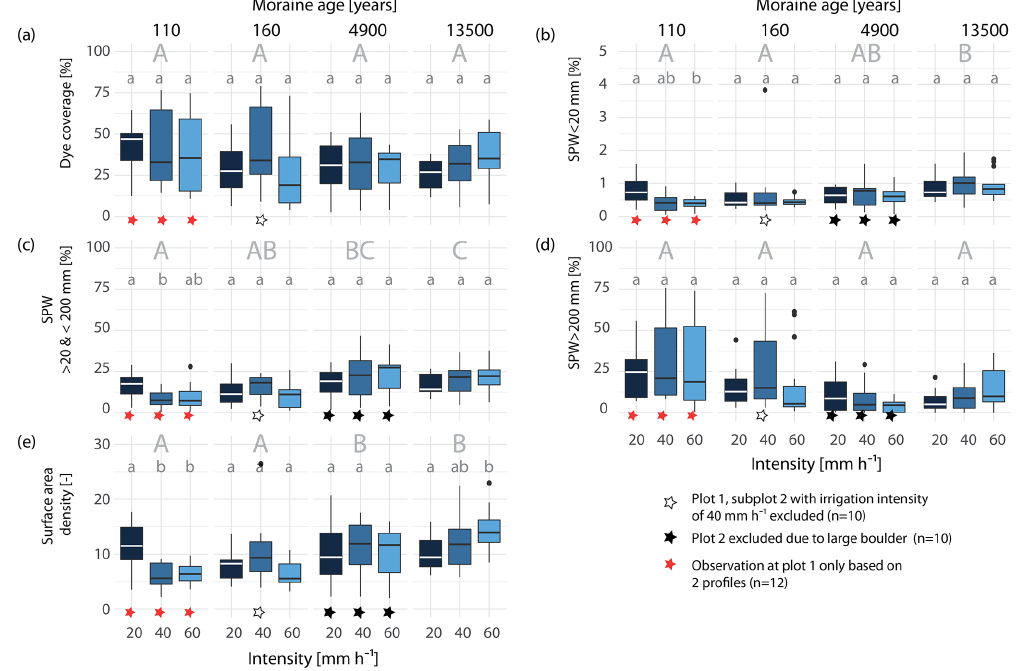
Figure 5. Box plots of dye staining characteristics compared across the three irrigation intensities and the four age classes (each box plot shows the data of 3 plots à 5 profiles, 15 profiles in total). (a) Dye coverage (volume density) in area percent of the entire soil profile, proportion of (b) stained path with (SPW) < 20mm, (c) 20mm < SPW < 200mm, (d) and SPW > 200mm in area percent of the entire soil profile, and (e) integral of the surface area density (measure for the number of flow paths) per age class and irrigation intensity. Upper case letters indicate the results of the Mood’s median test among the age classes. Different letters denote significantly different median values among the age classes (medians not shown). Lower case letters denote the results among the irrigation intensity in each age class.